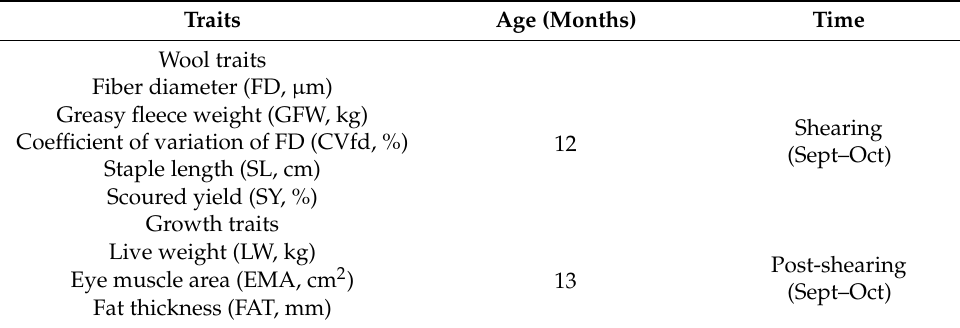
Table 2. Age of the animal, time of the measurements and data recorded in one-year-old female and male lambs